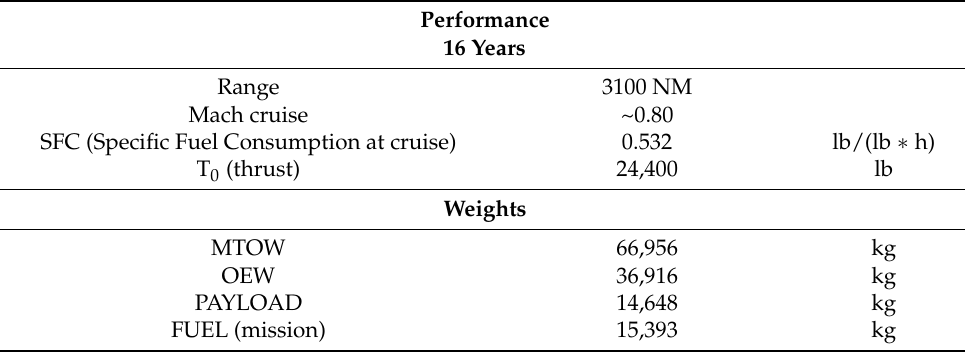
Table 15. Data for DOC estimation: reference mission data and weights.